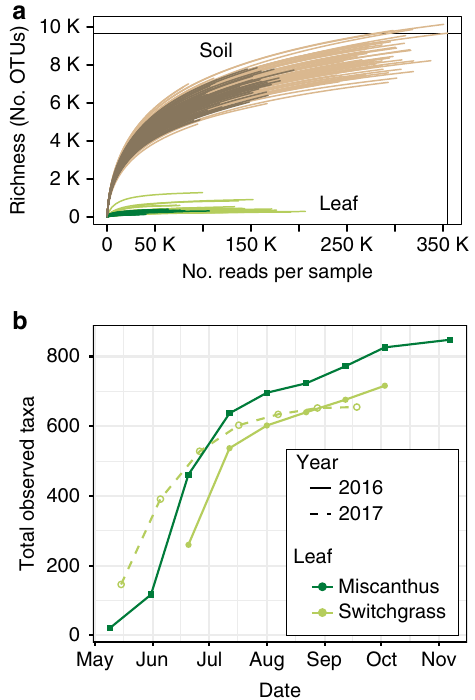
Fig. 1 Sequencing effort and alpha diversity for switchgrass and miscanthus phyllosphere (green lines) and soils (brown lines). Operational taxonomic units (OTUs) were de fi ned at 97% sequence identity of 16S rRNA gene amplicons. a Rarefaction curves of quality-controlled reads. The vertical line is the maximum number of sequences observed in a sample, and the horizontal line is the richness of that sample. b Phyllosphere richness accumulation for switchgrass (light green lines and circles) and miscanthus (dark green lines and squares) over time for 2016 (solid lines) and 2017 (dashed lines), using a dataset subsampled to 1000 sequences per